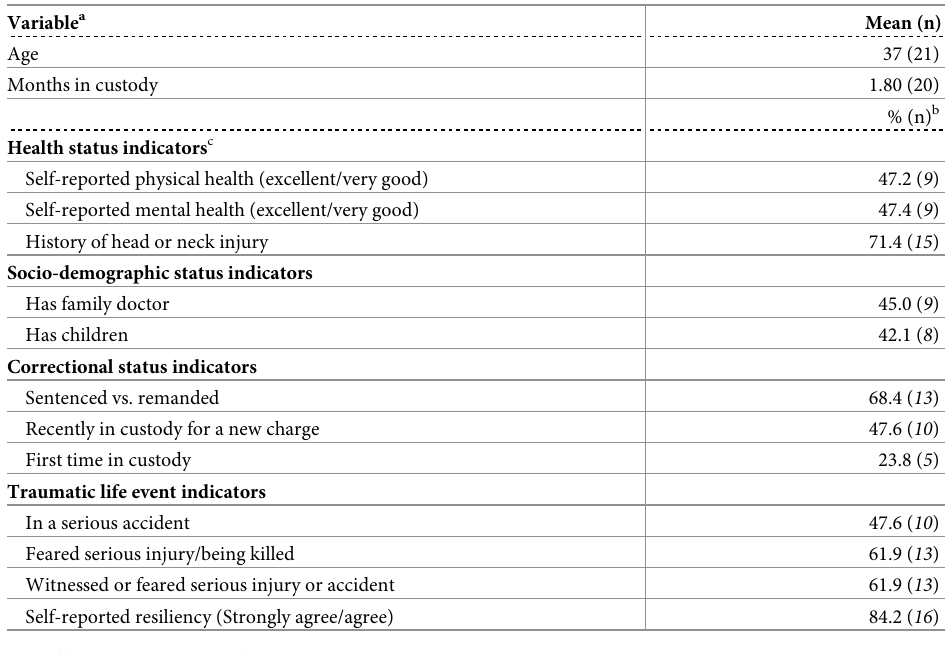
Table 1. Descriptive statistics for the study sample (n =